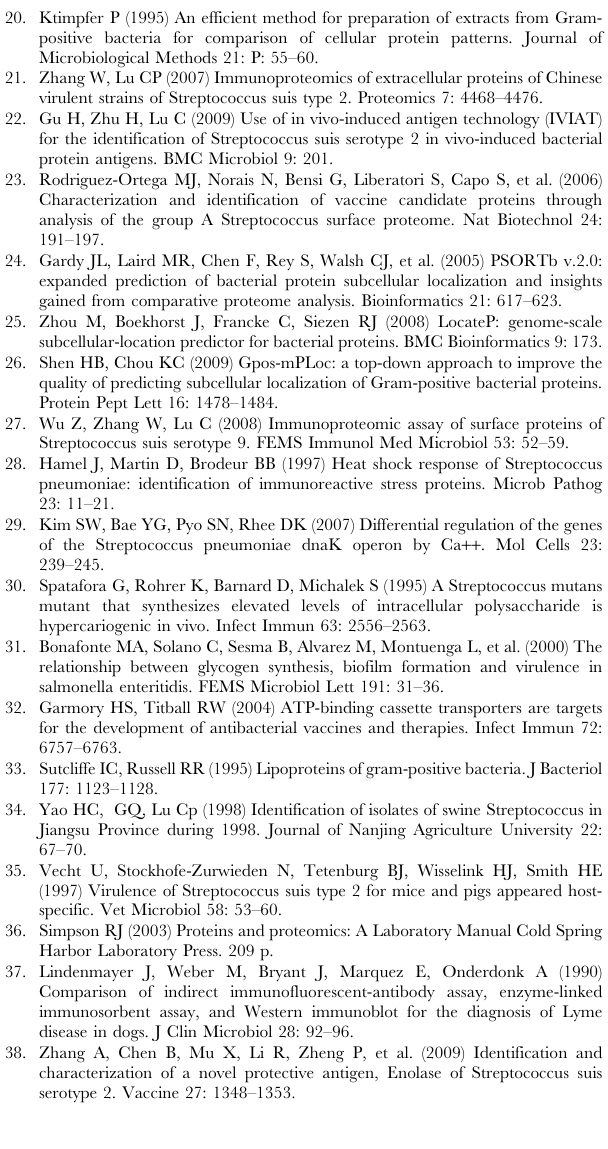
Table S2 Distributions of the HX2 gene in Streptococcus sp. Strains. a The serotypes of SS strains were confirmed by the agglutination test. N,